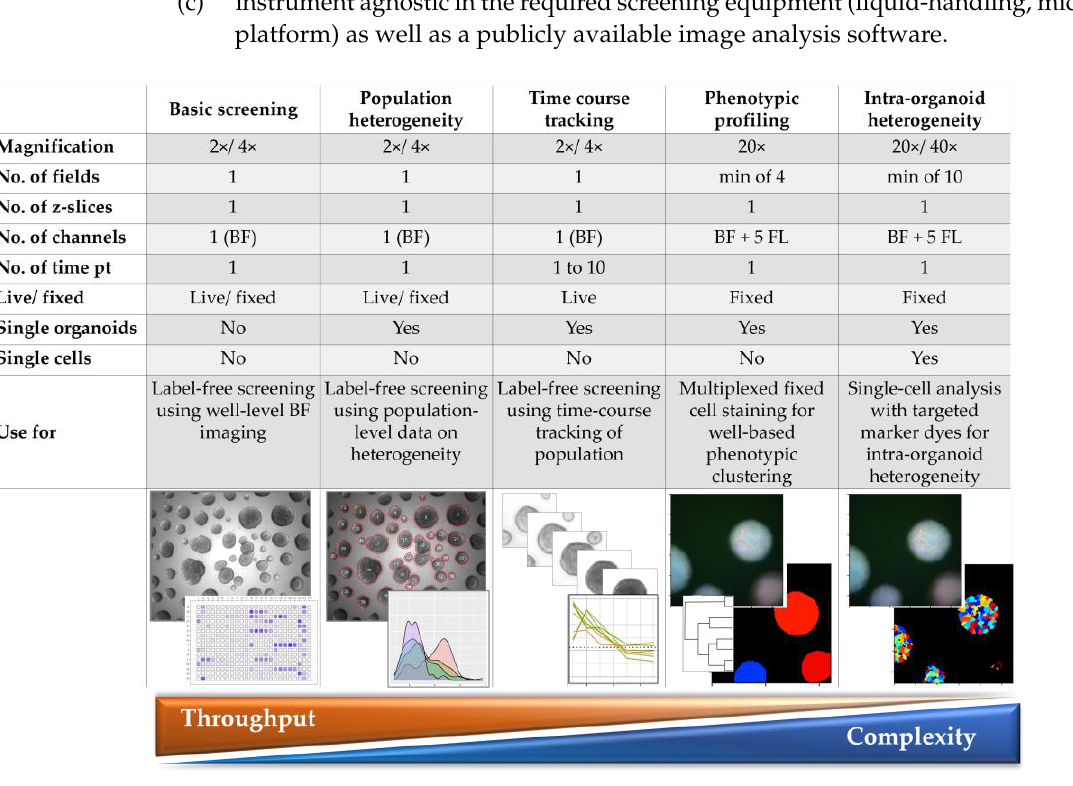
Figure 8. Overview of the range of interconnected methods across the spectrum of throughput and complexity and detail.